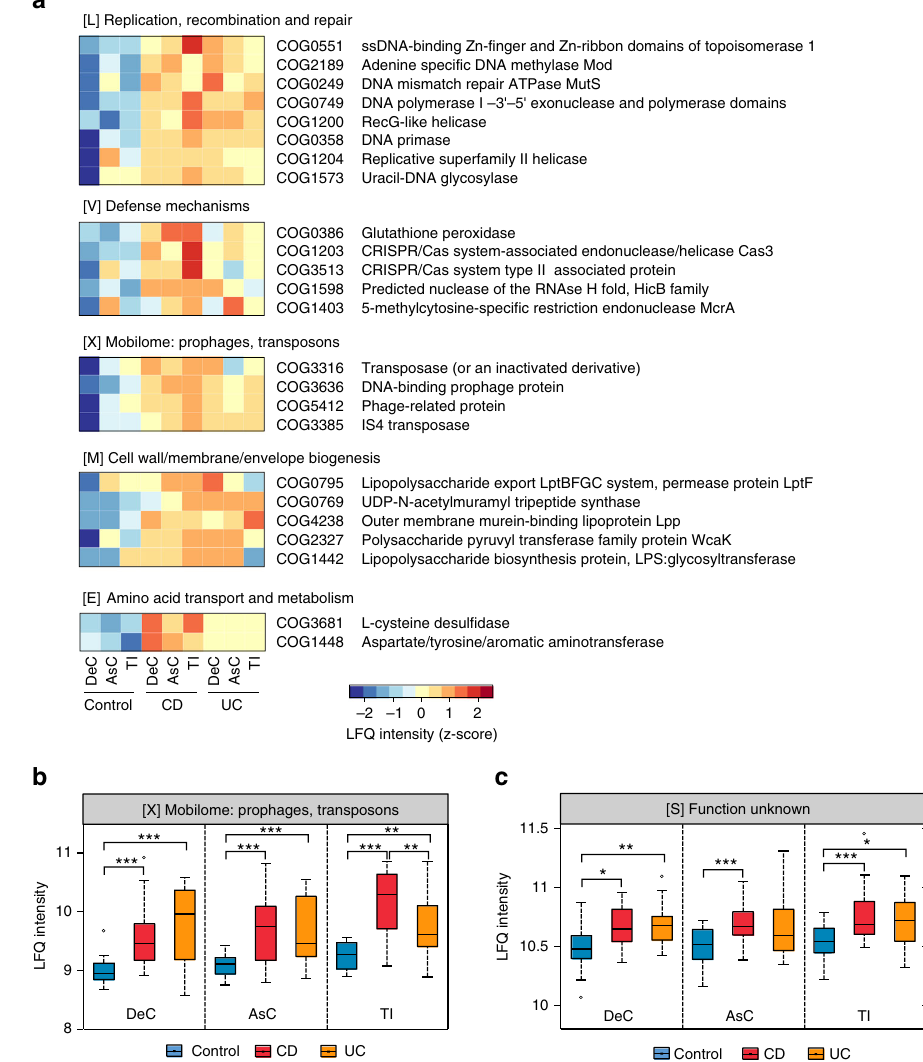
Fig. 3 Functional compositions of MLI microbiome in pediatric IBD patients. a Heatmap of differentially abundant COGs in IBD. Representative COG categories are shown and the colors indicate the average LFQ intensity for each subgroup of samples. Each row corresponds to a COG with the COG id and name indicated. b , c LFQ intensity of COG category X (mobilome) and category S (unknown function) in MLI microbiome of IBD patients. For the box plot, the bottom and top of the box are the fi rst and third quartiles, respectively. The middle line represents the sample median. Whiskers are drawn from the ends of the IQR to the furthest observations within the 1.5 times the IQR range. Outliers >1.5 times the IQR are indicated with circle. * p < 0.05, ** p < 0.01, *** p <